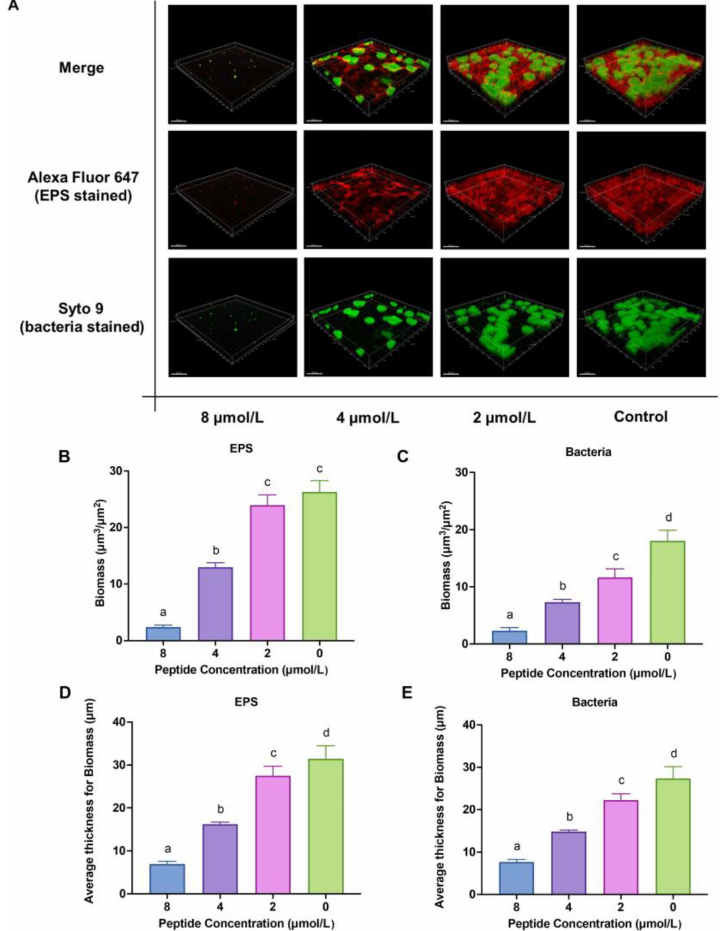
Figure 3. The three-dimensional structure of Streptococcus mutans biofilms under the LF-1 treatment for 24 h is observed by the CLSM, where EPS is stained red with Alexa Fluor 647 and bacteria are